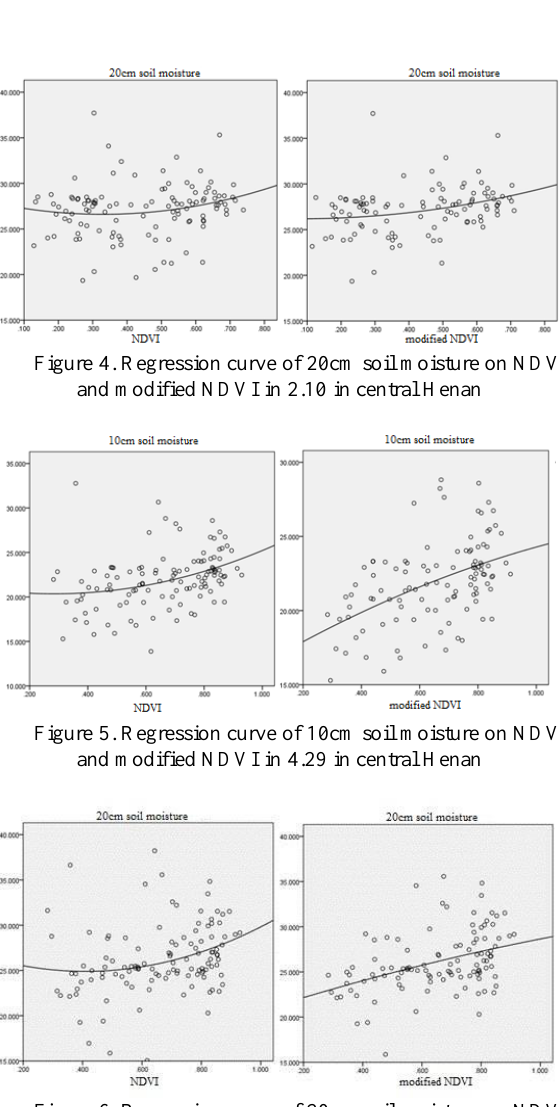
Figure 6. Regression curve of 20cm soil moisture on NDVI and modified NDVI in 4.29 in central Henan